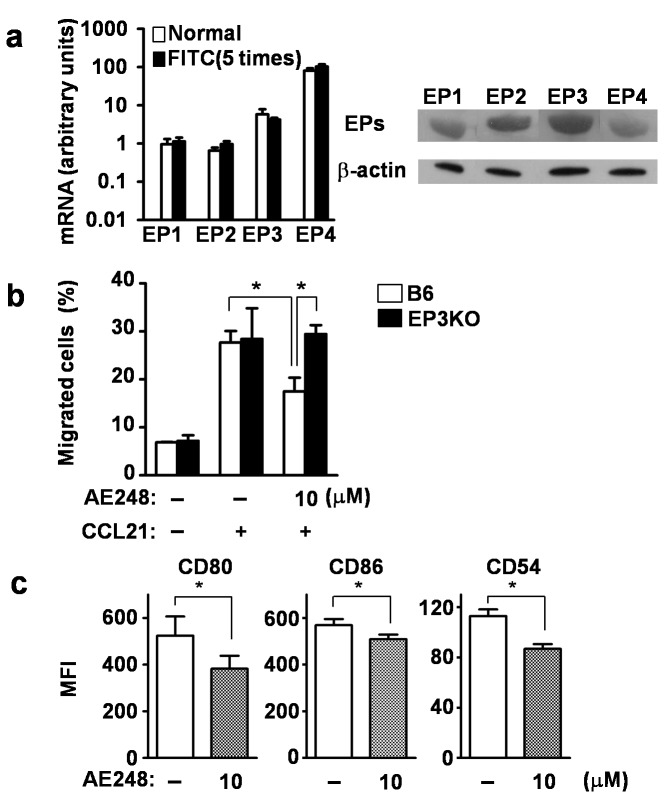
Inhibition of migration and maturation of LCs by EP3 agonist (AE248).(a) Expression of the four EP subtypes in CD11c+ epidermal cell suspensions (Langerhans cells) (Left; mRNA, Right; protein). (b) LCs treated with EP3 agonist for 24 hours were applied to the upper chamber of a transwell. After 3 hours incubation, the numbers of MHC class II + CD11c+ cells in the lower chamber including 100 ng/mL CCL21 were counted. White and black bars indicates the data from B6 and EP3KO mice, respectively (n=3). (c) Expression of maturation markers (CD80, CD86 and CD54) on LCs were analyzed by FACS 24 hours after EP3 agonist treatment (n=3). *p<0.05. MFI, mean fluorescence intensity.